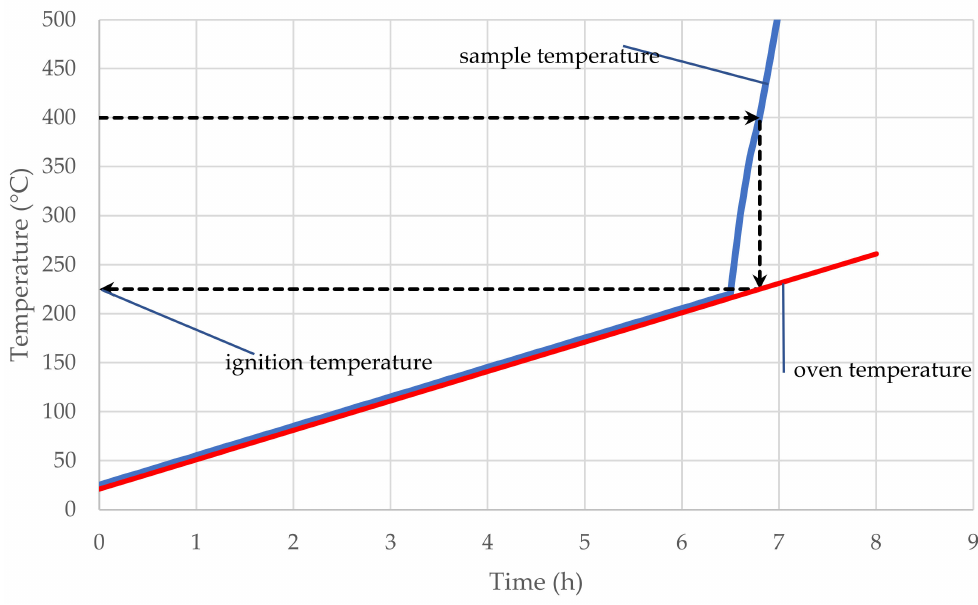
Figure 2. Procedure for determining the auto-ignition temperature of a sample based on test